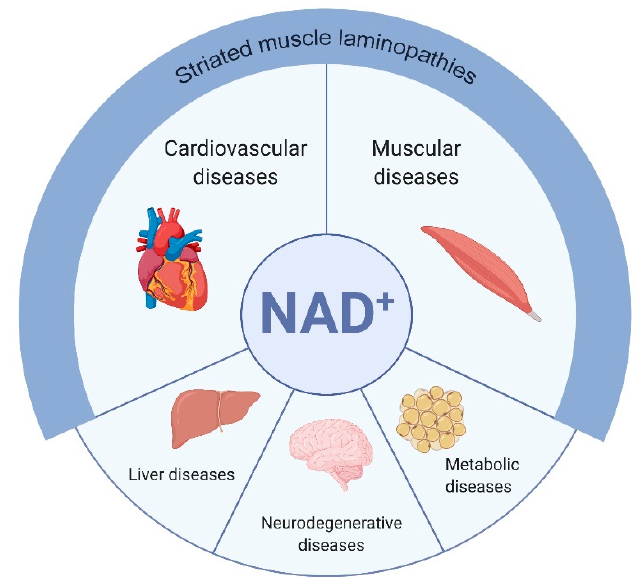
Figure 3. Central role of NAD + in pathological conditions: impaired NAD + levels are involved in the development of pathologies including cardiovascular, muscular, liver, neurodegenerative and metabolic diseases. Given that cardiac and skeletal muscles are the main a ff ected tissues in striated muscle laminopathies, boosting NAD + levels is expected to be an e ffi cient treatment to improve patients health